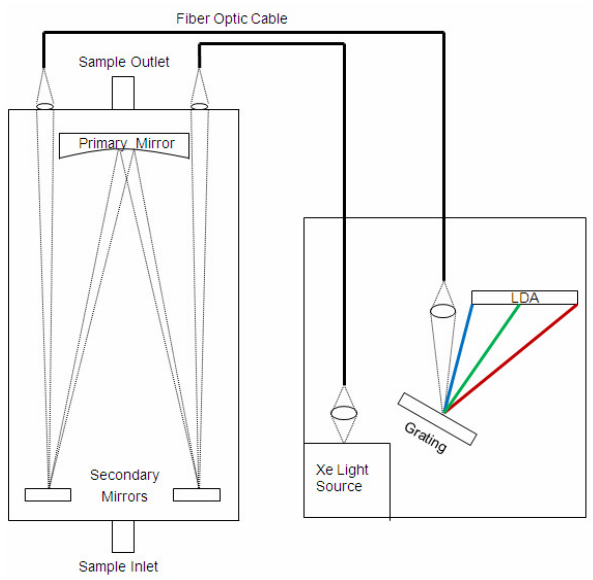
Fig. 2. A schematic of the benchtop AE-DOAS system. Light from Figure 2. A schematic of the benchtop AE-DOAS system. Light from the xenon lamp in the rack 2 the xenon lamp in the rack mountable spectrometer (shown on the mountable spectrometer (shown on the right) is focused onto a fiber optic cable for transfer into 3 right) is focused onto a fiber optic cable for transfer into the multi- pass gas cell (shown on the left). After a number of passes in the the multi-pass gas cell (shown on the left). After a number of passes in the gas cell, the reflected 4 gas cell, the reflected light is focused onto a second fiber optic cable and detected by the light is focused onto a second fiber optic cable and detected by the spectrometer. 5